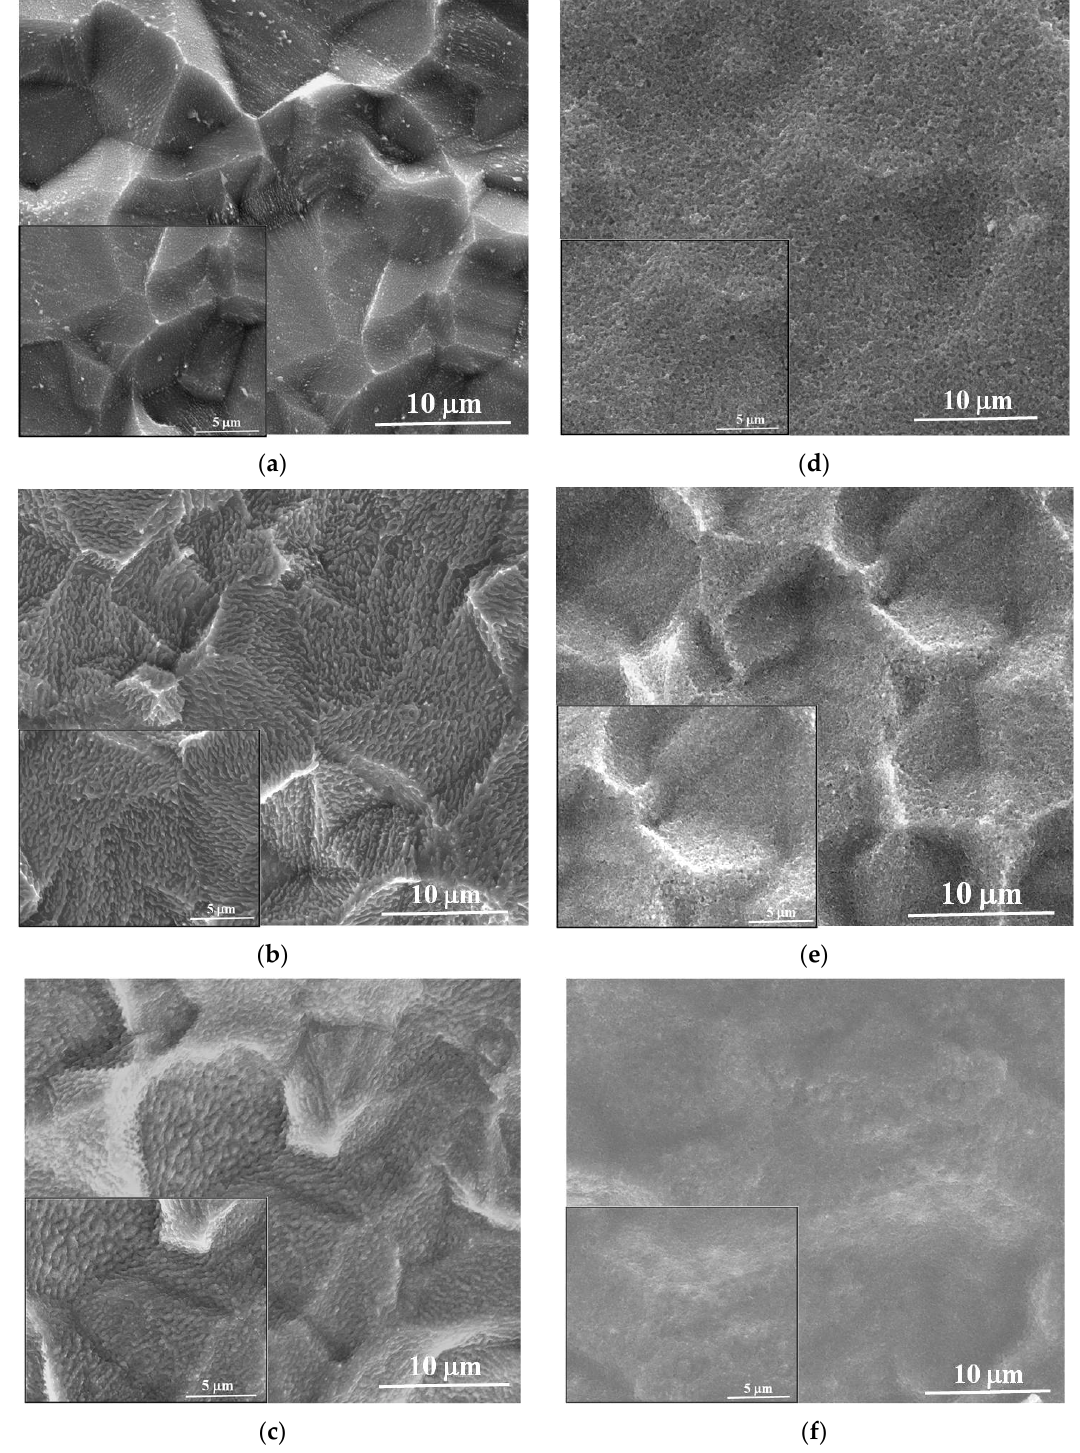
Figure 3. SEM images for the Ti-TiO 2 layers as S1 ( a ); S2 ( b ); S3 ( c ) and sensors Ti-TiO 2 -CuMnO 2 as S1a ( d ); S2a ( e ); S3a ( f ).